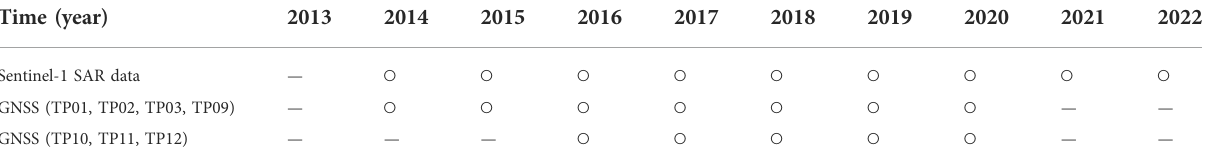
TABLE 1 Time axis of the SAR data, GNSS data, and deep deformation monitoring data. Time (year)